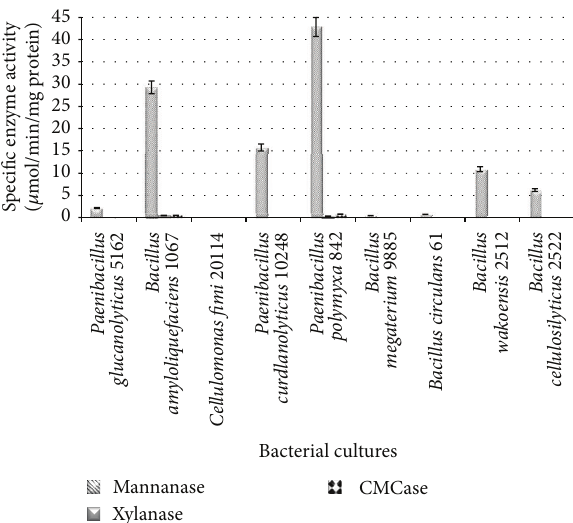
Figure 3: Specific CMCase, xylanase, and mannanase activities of cellulolytic bacteria grown in LBG